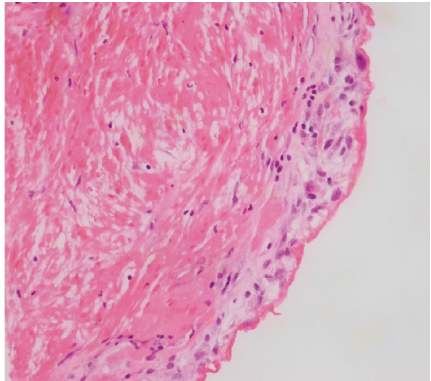
Figure 3: H&E stain of biopsy of pericardial tissue showing thickened pericardial tissue with acute and chronic in fl ammation and reactive mesothelial hyperplasia.